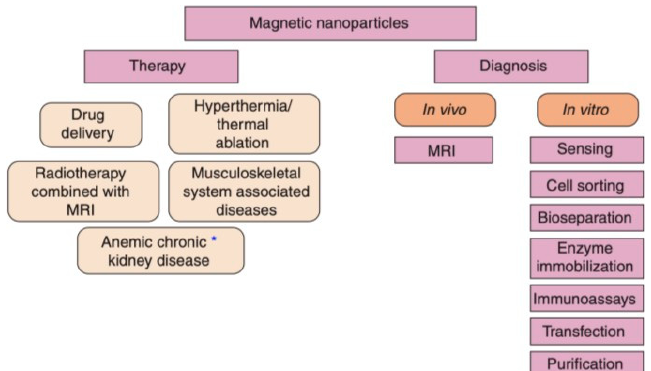
Figure 3. The range of available biomedical applications for MNPs. The asterisk (*) represents either diagnostic or therapeutic applications that are undergoing clinical trials [25].